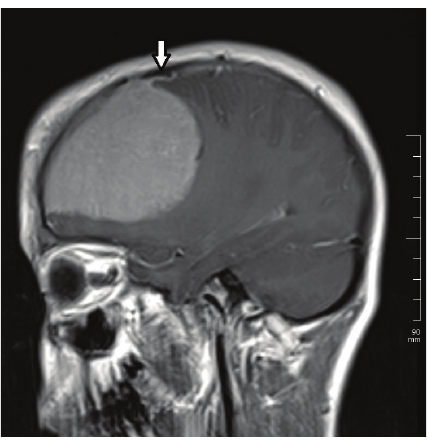
Figure 5: Magnetic resonance imaging. Sagittal T1-weighted MRI scan shows dural tail